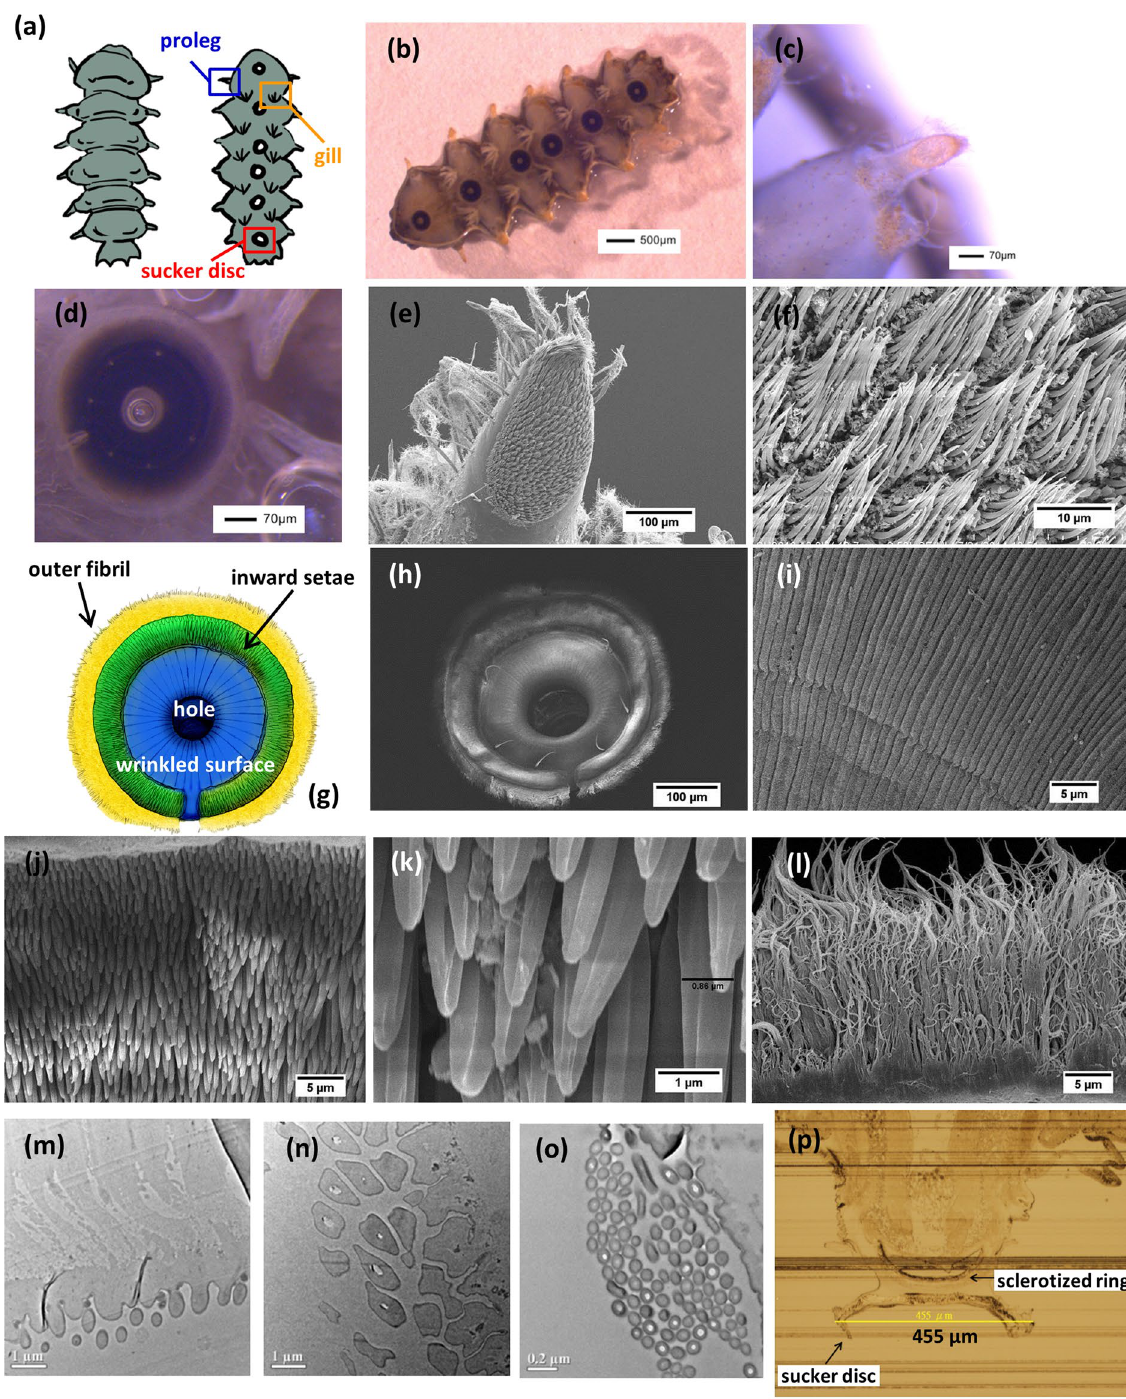
Figure 1. ( a ) Illustration of larva of Blepharicera sp. (Diptera) indicating that prolegs, gills and sucker discs can be observed in ventral side. ( b ) A larva of Blepharicera sp. attach under a glass slide. Morphological views of suckers. ( c ) Stereoscopic image of proleg of the larva of Blepharicera sp. and the sucker ( d ) attaching to a surface (47 μ m in radius of the hole and 195 μ m in radius of whole sucker) and ( e , f ) SEM images of proleg showing that setae are arranged in an array. ( g ) Illustration picture and ( h ) SEM image of a sucker of larva of Blepharicera sp., which can be divided into four parts: ( i ) wrinkled surface, ( j , k ) inward setae and (l) outer fibers. TEM images of ( m ) the layer of wrinkled surface revealing the thickness of which is ~1.5 μ m, ( n ) the cross-section of the inward setae showing and hollowed structure and ( o ) the cross-section of the outer fibers indicating the diameter of which is ~0.05 μ m. ( p ) The histological microtome image showing sucker disc and sclerotized